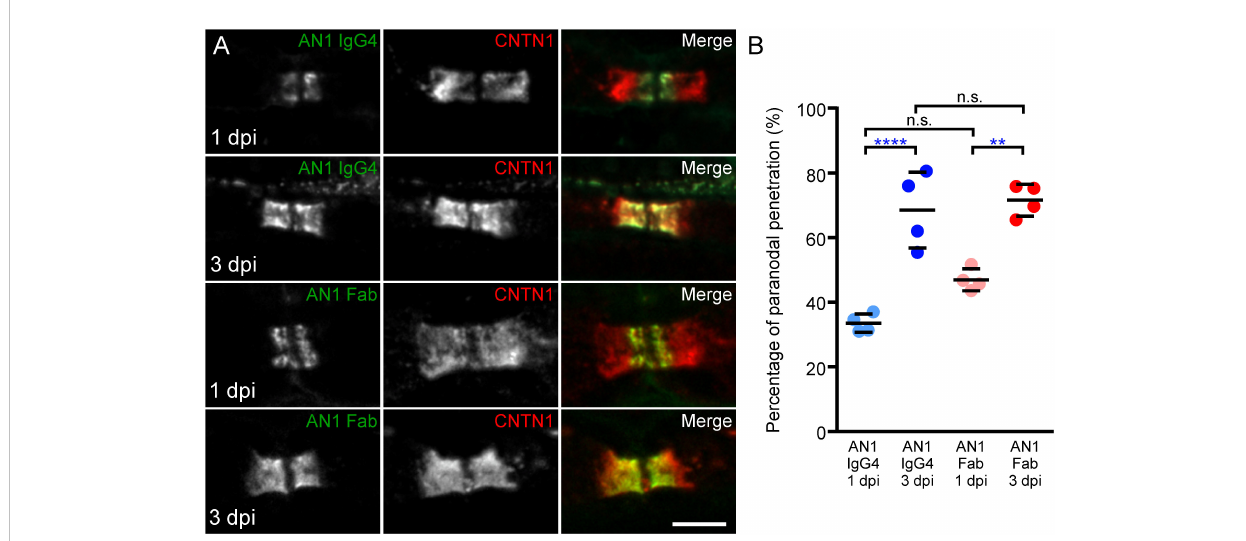
FIGURE 3 Mono- and bivalent IgG4 in fi ltrate paranodal regions. (A) These are teased sciatic nerve fi bers from adult Lewis rats which have received a single intraneural injection of native CNTN1 reactive IgG4 (top panels; n = 4 at each time point) or monovalent Fab (lower panels; n = 4 at each time point). Nerves have been collected 1- or 3-days post-injection (dpi) and have been stained for CNTN1 (red) and IgG (green). (B) The percentage of IgG in fi ltration was measured in each animal at 1 and 3 dpi, and the mean percentage of in fi ltration was calculated (n = 4 for each condition). The paranodal in fi ltration of native IgG4 reactive to CNTN1 was signi fi cantly higher at 3 dpi compared to 1 dpi (**** P <0.0001, by one-way ANOVA followed by Bonferroni ’ s post-hoc tests). The percentage of in fi ltration of monovalent Fab was also signi fi cantly higher at 3 dpi compared to 1 dpi (** P <0.01 by one-way ANOVA followed by Bonferroni ’ s post-hoc tests). No signi fi cant difference was seen between monovalent Fab and native IgG4 in fi ltration at both times. Bars represent mean and S.D. Scale bar: 5